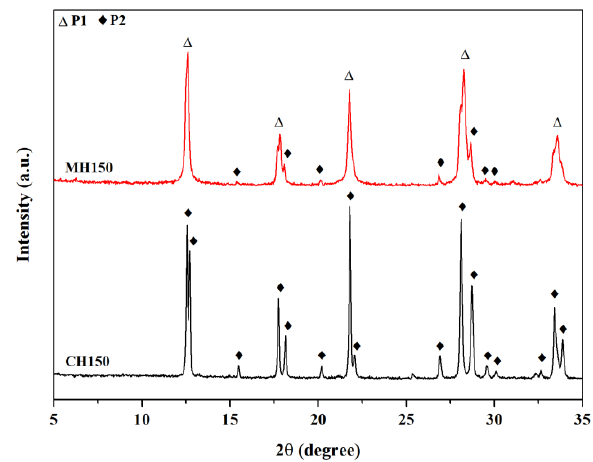
Figure 1. Powder X-ray diffraction (XRD) patterns of zeolite products from conventional and microwave-assisted hydrothermal methods with single crystallization at 150 ◦ C for 24 h (CH150) and 1 h (MH150).